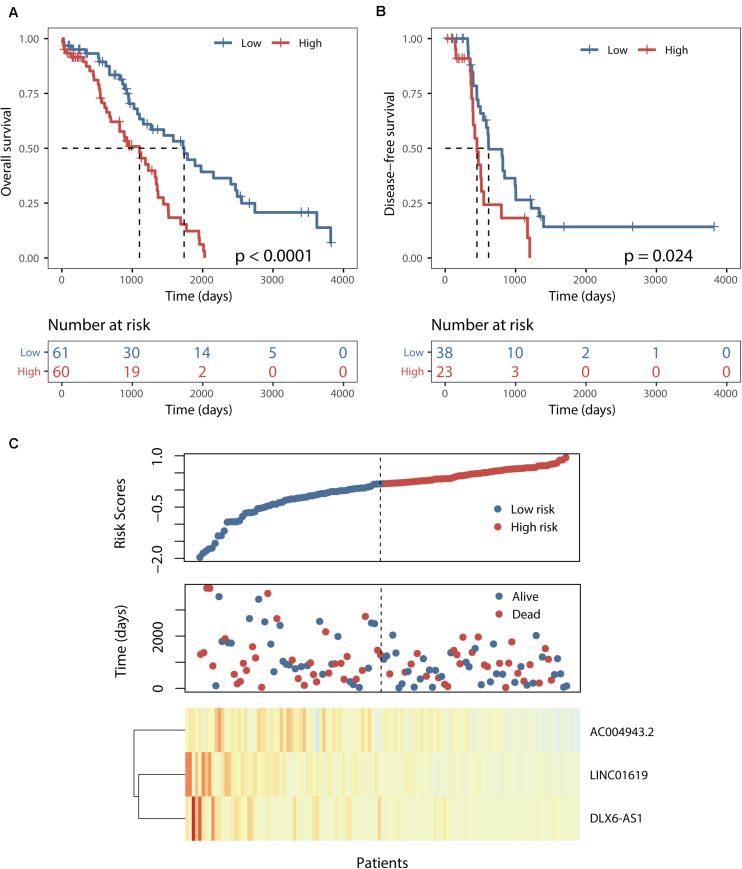
Identification of a BRCA1/2-directed lncRNA signature (BRCALncSig) in the training set. (A) Kaplan–Meier survival curves of overall survival between high-risk and low-risk patients. (B) Kaplan–Meier survival curves of disease-free survival between high-risk and low-risk patients. (C) Risk scores distribution and expression pattern of the BRCALncSig.